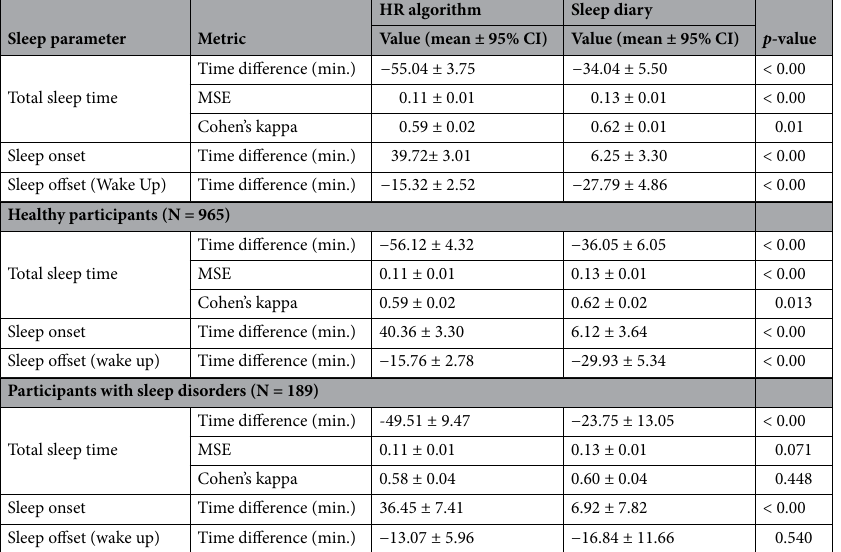
Table 6. Results for the MESA dataset. Both the HR algorithm and sleep diaries are evaluated against PSG. Results are also shown for the subset of healthy participants and participants with sleep disorders. MESA TST